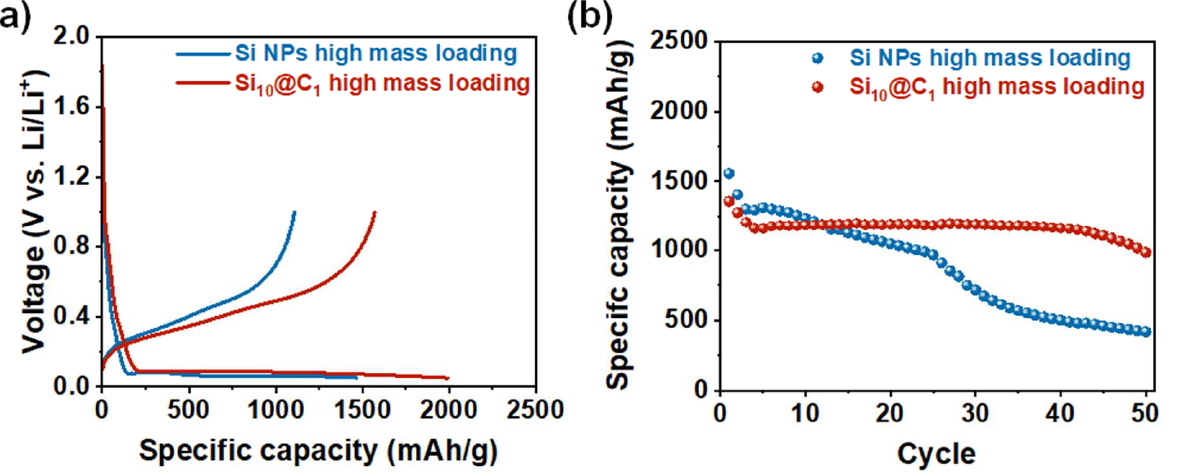
Figure 5. Electrochemical performances of the Si@C‖Li half-cell with a high mass loading (~1.2 mg cm −2 ): ( a ) galvanostatic charge–discharge profiles of the SiNPs and Si@C electrode with a high mass loading; ( b ) cycle performance of the SiNPs and Si@C electrode with a high mass loading at a rate of 0.5 C.